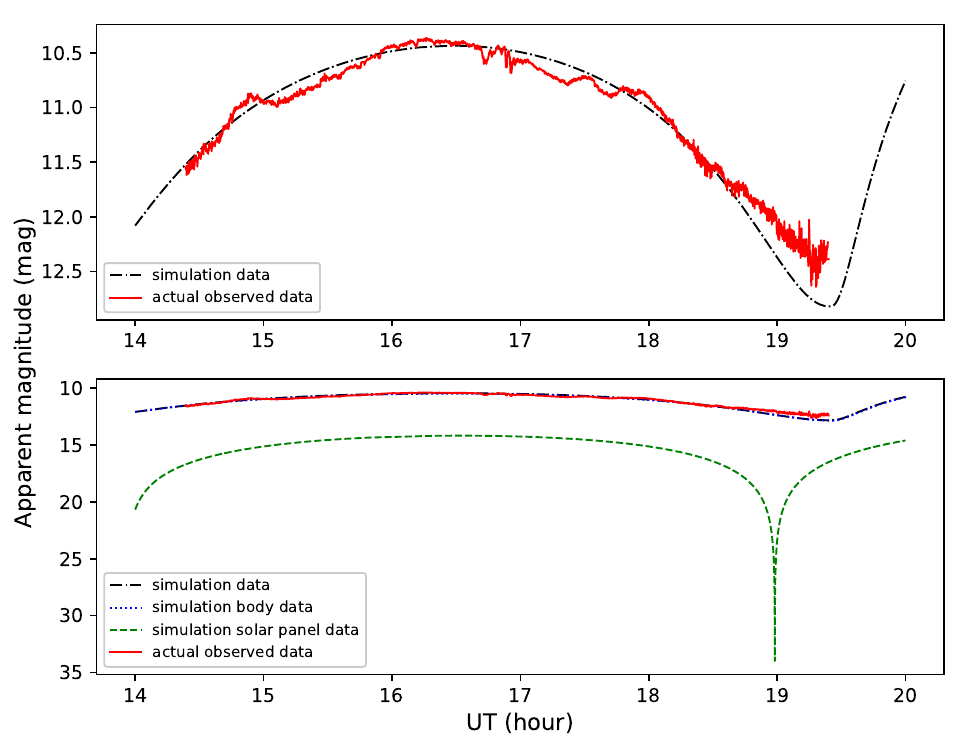
Figure 14. The synthetic light curve of Object